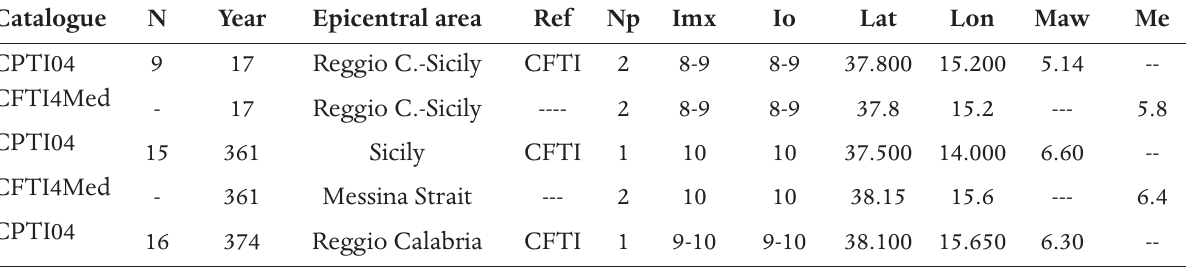
Table 1. A comparison between 1st-4th century AD earthquakes in the studied area, as depicted by CPTI Working Group [2004] and CFTI4Med [Guidoboni et al. 2007-2013]. N=reference number; Year=origin time; Epicentral area: maximum effect area; Ref.: source catalogue; Np: num- ber of macroseismic observations; Imx: maximum observed intensity; Io: Estimate epicentral intensity; Lat and Lon: geographical epicentre coordinates; Maw and Me: equivalent magnitude.